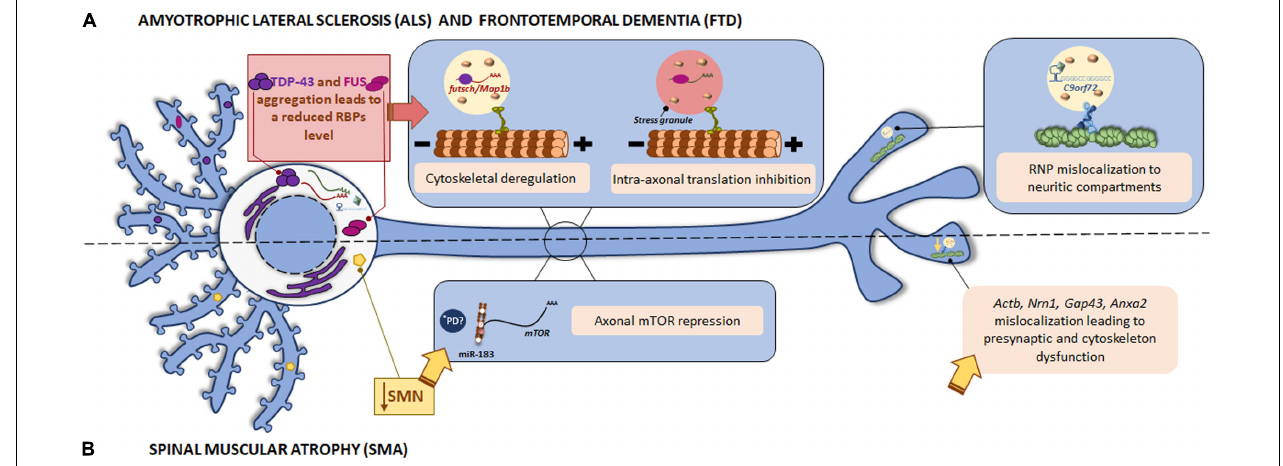
FIGURE 3 | Local translation defects in ALS/FTD and SMN. (A) Among ALS/FTD-linked proteins, TDP-43, FUS, and C9orf72 are found. The RBPs TDP-43 and FUS play a role in RNA metabolism. The aggregates usually found in ALS and FTD patients impair TDP-43 and FUS function leading to altered mRNA localization and the consequent cytoskeletal deregulation and stress-mediated intra-axonal translation inhibition, respectively. The GGGCC repeat expansion in the C9orf72 mRNA triggers its assembly in RNP granules, which are erroneously localized to neuritic compartments and affect to nerve branching. (B) Loss of SMN is the main cause of SMA. SMN is involved in the localization of mRNAs to the axonal compartment. SMN defects lead to Actb , Nrn1 , Gap43, and Anxa2 mislocalization with important impact in neurite growth, presynaptic function, and cytoskeleton plasticity. SMN also controls the regulator of local translation mTOR through miR-183. *PD miRNAs are also involved in the translation repression induced by mutant LRRK2 in PD. Due to local miRNAs have been identified as contributors to other pathologies, a similar local mechanism could participate in the pathogenesis of PD.